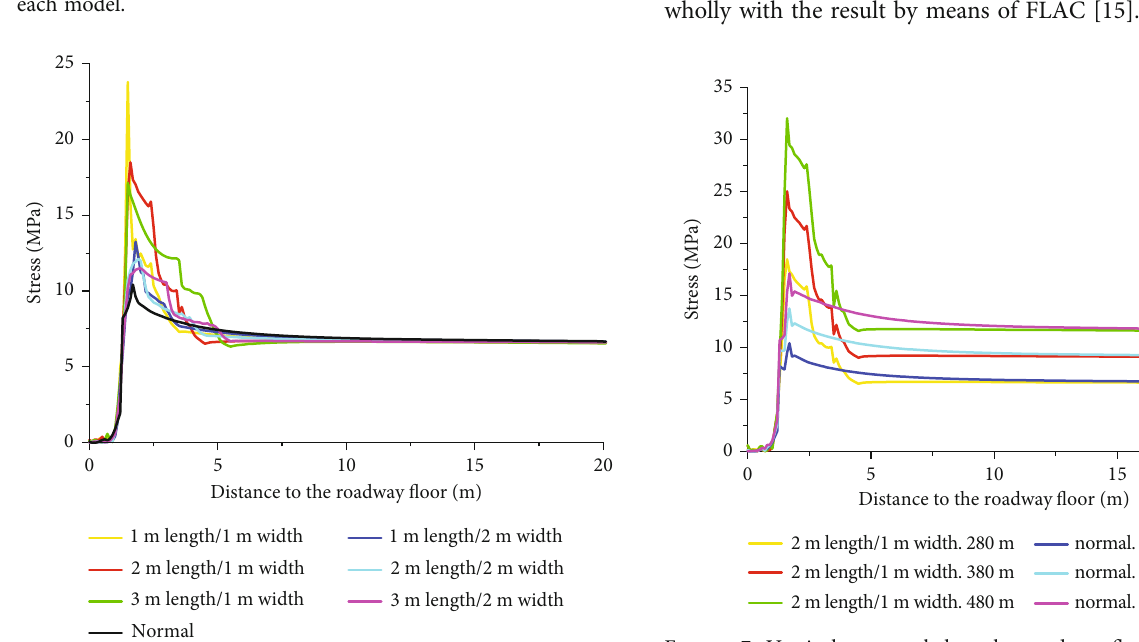
Figure 4: Horizontal stresses below the fl oor of the heading face for each model.